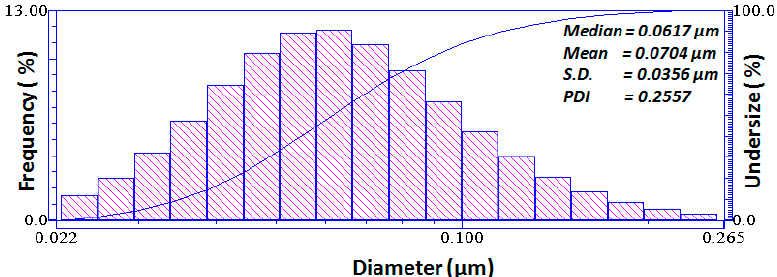
Figure 4. DLS pattern of as-synthesized AgNPs.